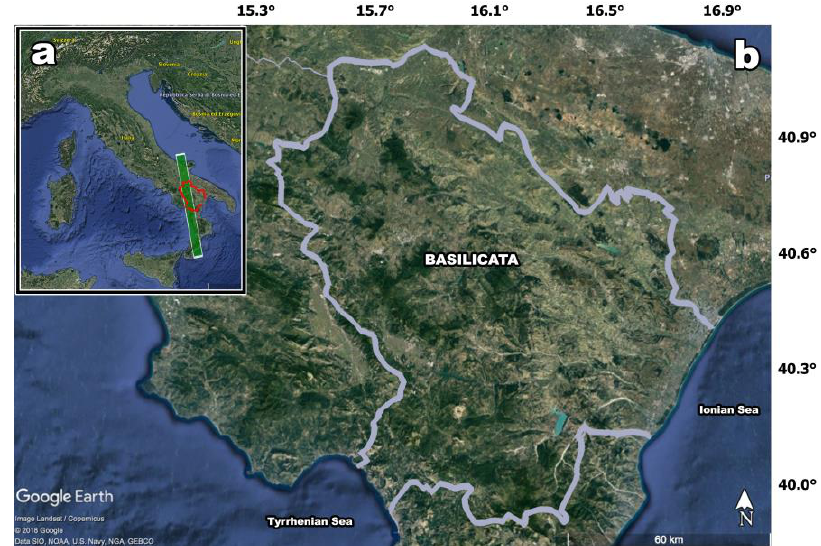
Figure 7. Geography of the study area: ( a ) The Italian Peninsula. The red demarcation lines identify the Basilicata region; the green rectangle identifies the used COSMO-SkyMed ascending strips. ( b ) Macro of the Basilicata region, where it is possible to see the two sea outlets. Shown are the Google Earth’s optical images acquired by Landsat satellites on 14 December 2015.